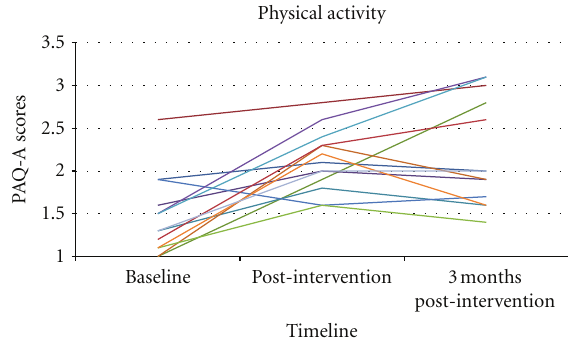
Figure 1: Adapted Physical Activity Questionnaire for Older Children scores at baseline, post-intervention, and three-month post-intervention time